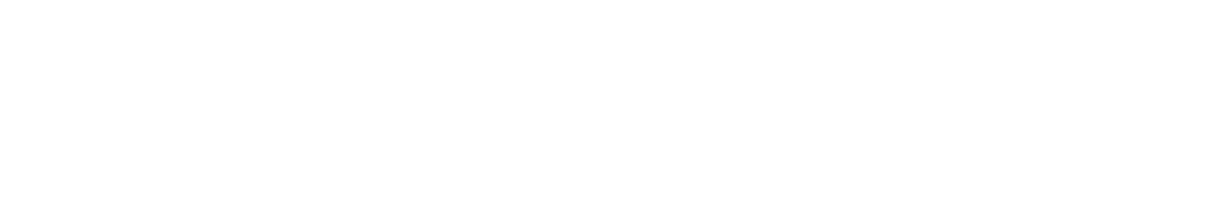
Frontiers in Cell and Developmental Biology |